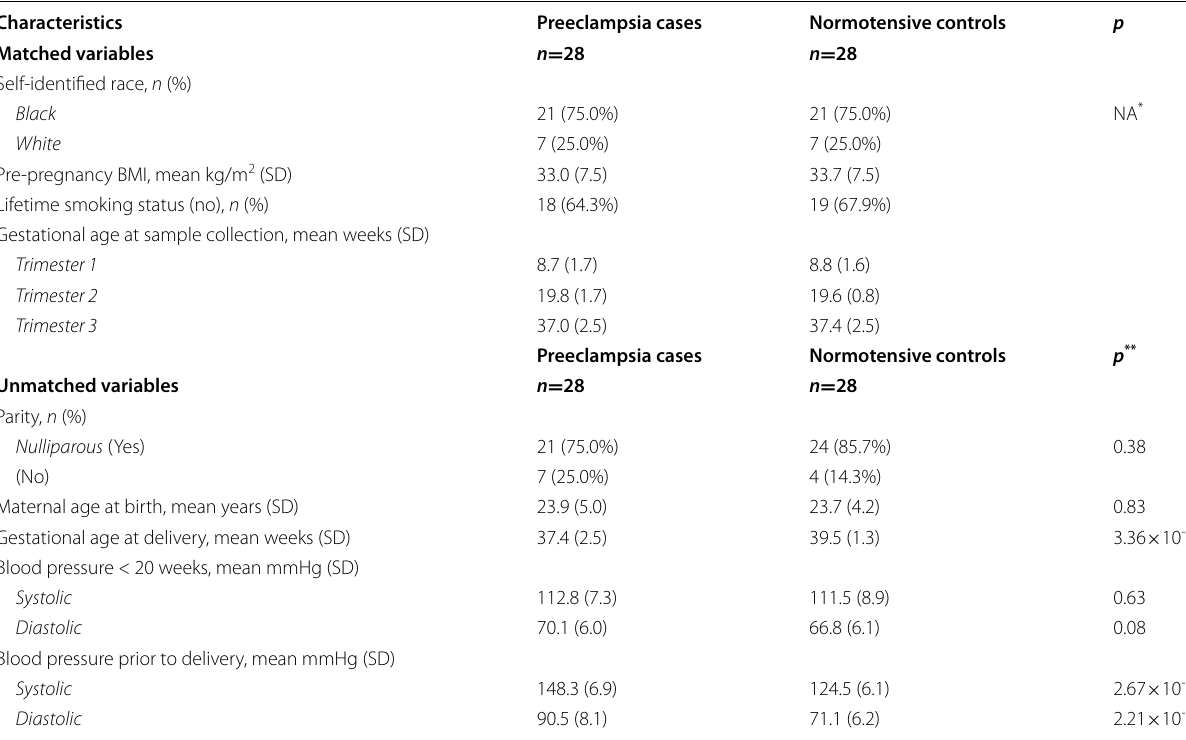
Table 1 Demographic and clinical characteristics of participants in the discovery